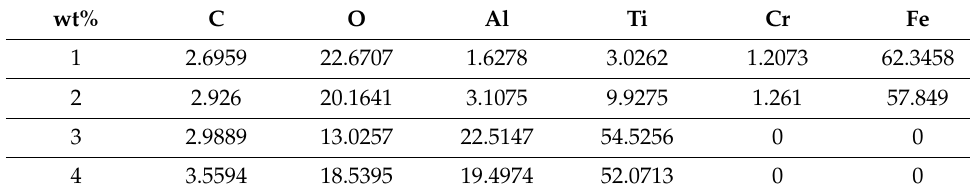
Table 3. SEM-EDS compositional analysis of the yellow marks of Figure